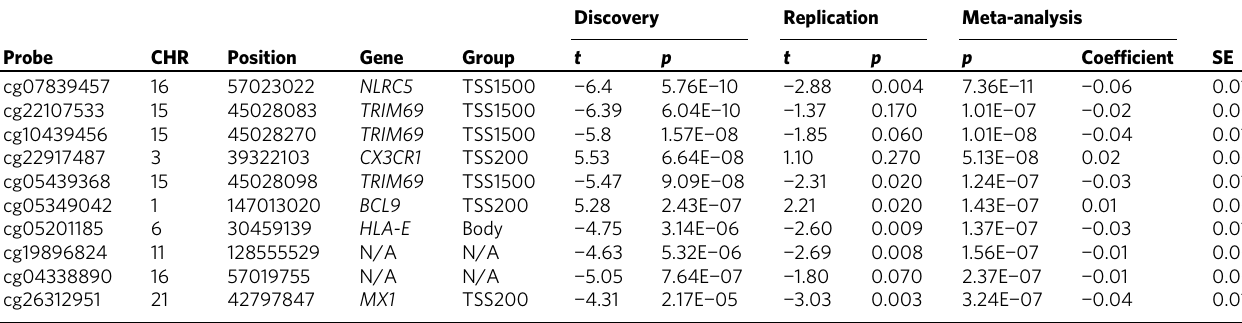
Table 2 Epigenome-wide DNA methylation sites associated with IDU comorbid HCV in HIV-infected individuals Discovery Replication